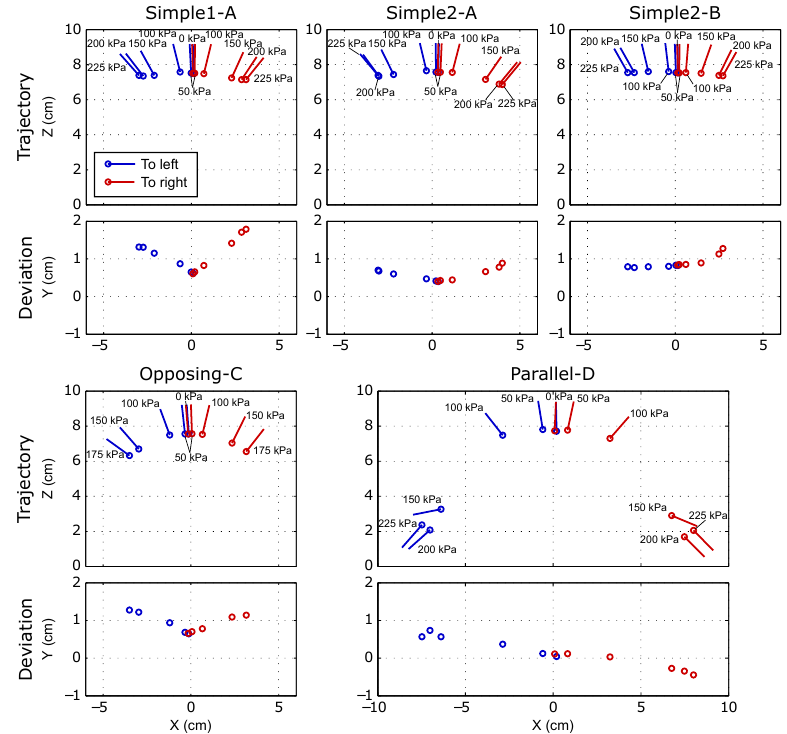
Figure 7. Abduction-adduction trajectory results. Lengthwise extension can be seen as straight motion of the tip to the sides, instead of a round curve. Opposing-C had the roundest motion and least lengthwise extension, and it behaved most like a pivot joint. Parallel-D had a wider motion than the others due to its different structure and had the largest lengthwise extension. It is also possible to see the actuators’ nonlinear motion pattern, similar to the flexion